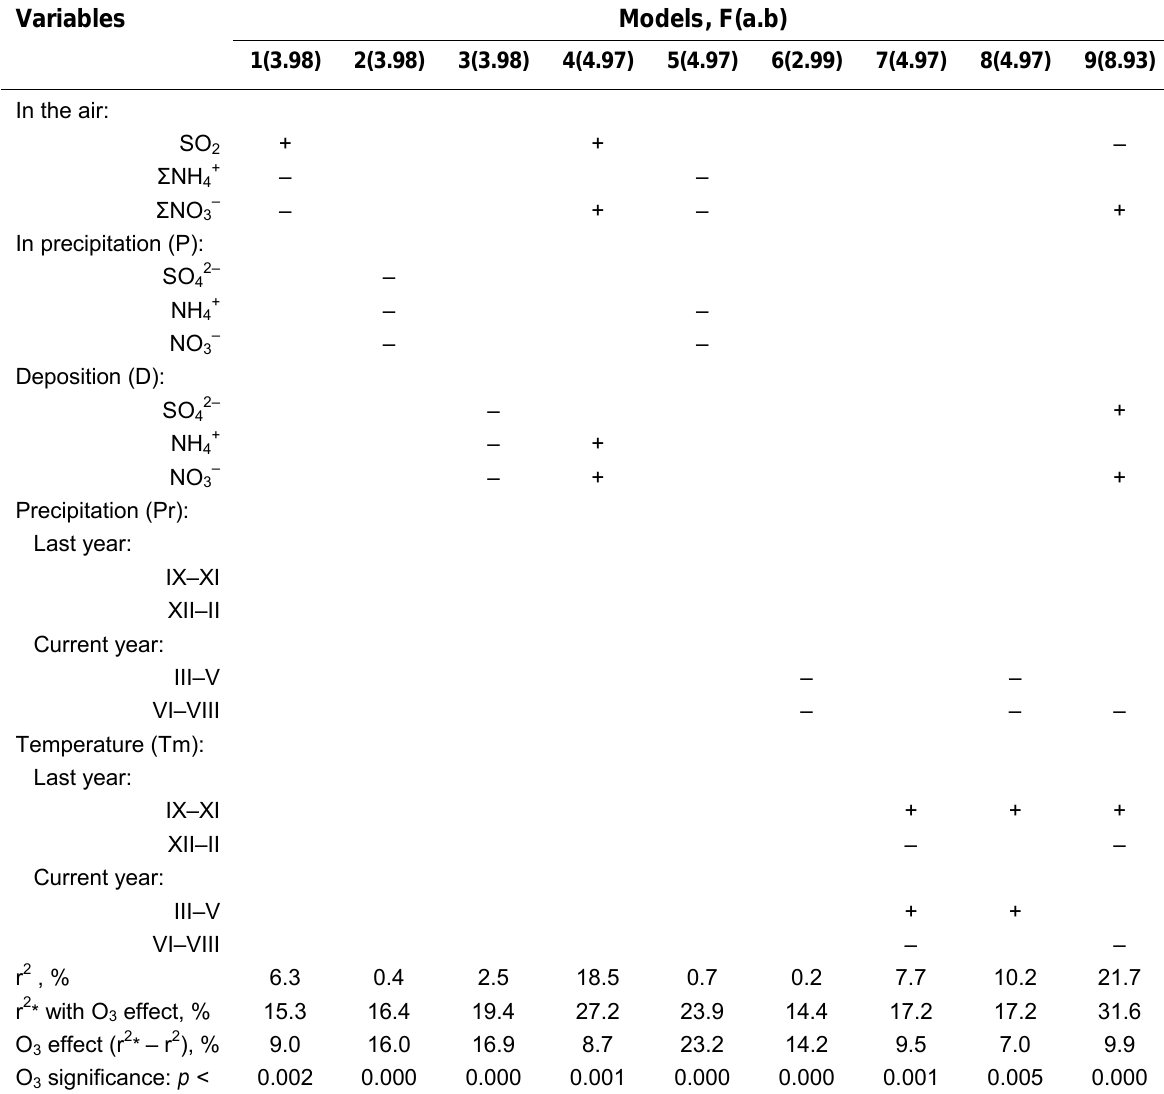
to the Integrated Impact of Different Environmental Factors on Contribution of Ambient O 3 Residual of Pine Stems